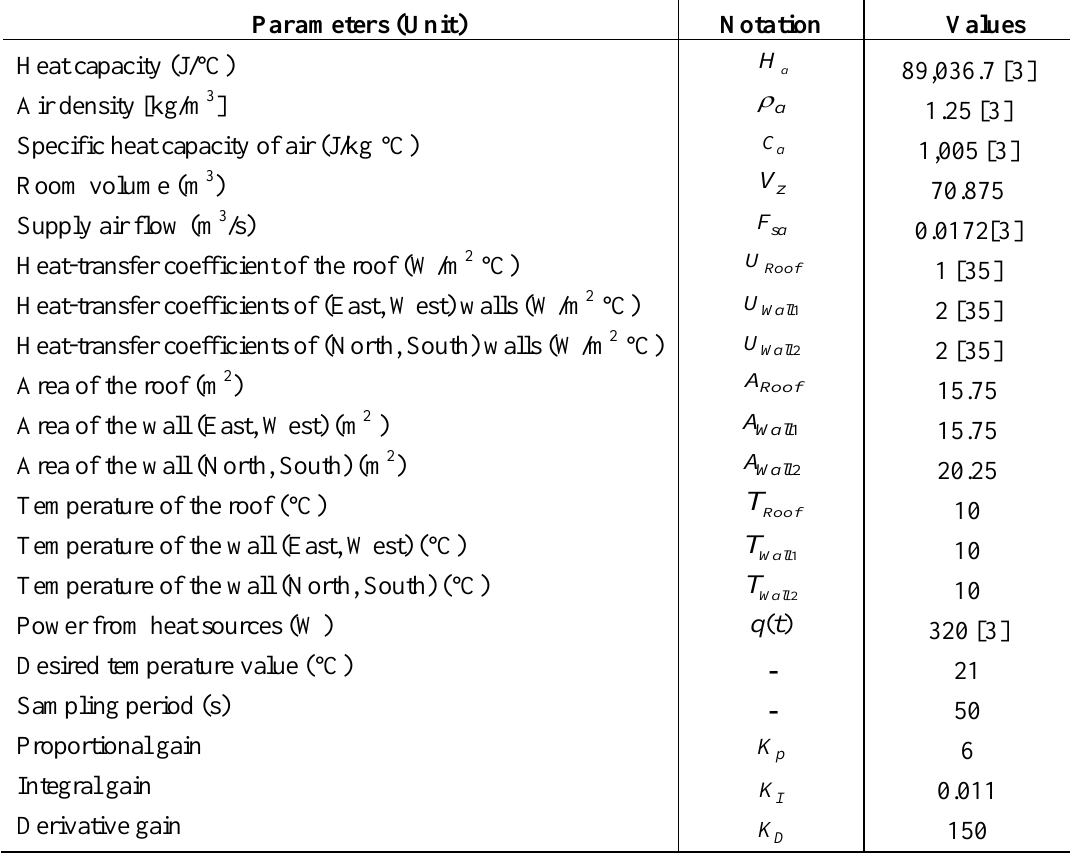
Table 1. Control system